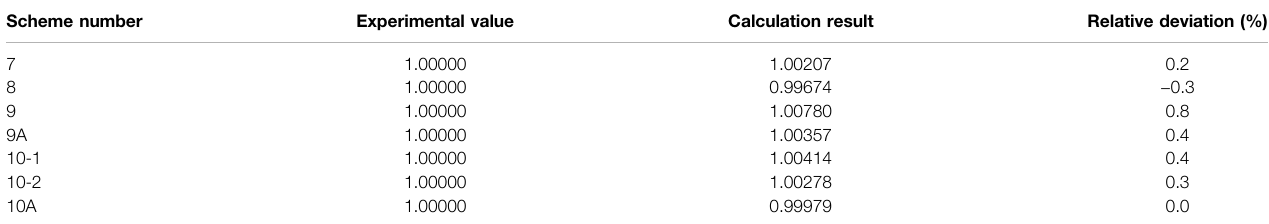
TABLE 3 | k eff veri fi cation calculation results of core critical rod position.